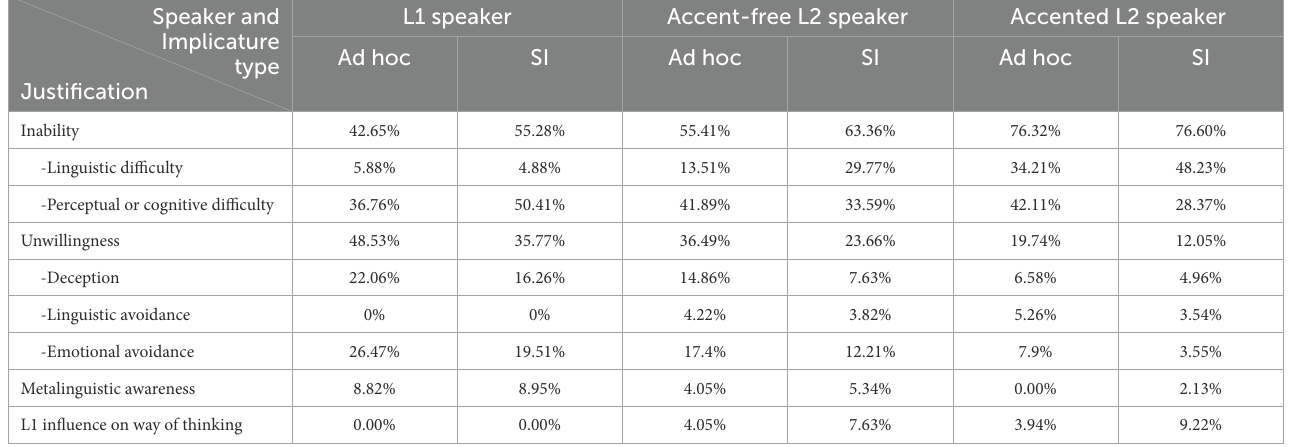
TABLE 3 Justifications given for underinformative utterances as categorized by speaker type and justification type. Speaker and